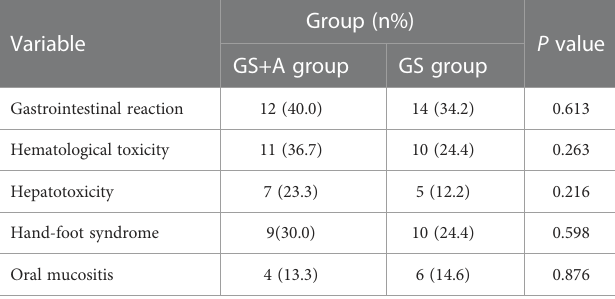
TABLE 3 Treatment-related adverse events of in